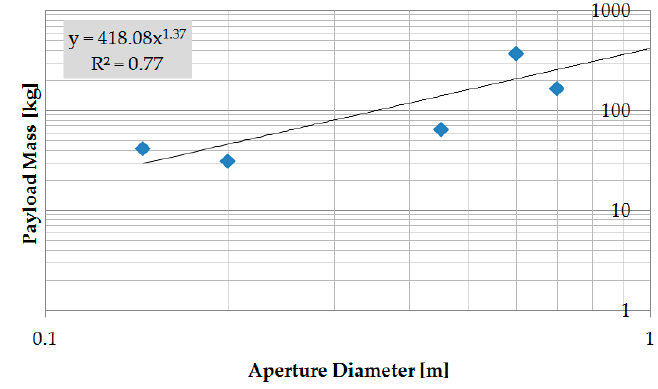
Figure A1. Sensor payload mass vs. aperture diameter. Table A1. Figures of merit, scaling and weighting factors in single-objective optimization.